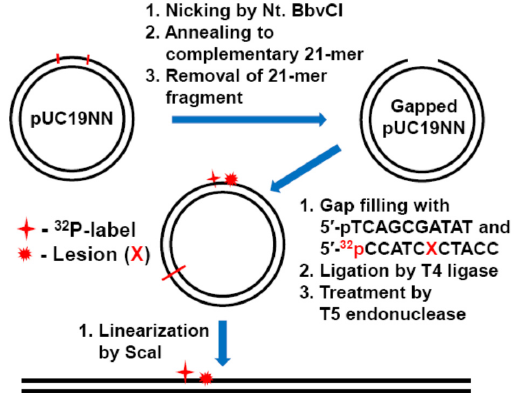
Figure 2. Covalently closed circular and linearized plasmid (2686 bp) containing site-specifically positioned guanine lesions (X) and a radioactive 32 P-internal label. The circular plasmid substrates were generated by gapped-vector technology from a pUC19NN plasmid containing two Nt. BbvCI restriction sites [21,22]. The linearized plasmid substrate with the lesion X positioned at the 945th nucleotide counted from the 5 ′ -end, was prepared by the selective cleavage of the circular plasmid with a unique ScaI restriction enzyme that generates blunt end cleavage products. The gapped plasmid derived from the nicking of pUC19NN with the Nt. BbvCI re- striction enzyme, was filled with the 5 ′ -phosphorylated oligonucleotides 5 ′ -pTCAGCGA- TAT and 32 P-endlabeled 5 ′ - 32 pCCATCXCTACC (where the lesion X = Gh, S -Sp, 8-oxoG, or cis -B[ a ]P-dG), and was ligated to the plasmid by T4 ligase. The reaction products were treated with T5 exonuclease to digest any linear and nicked plasmids [79–81]. The cleav- age of the covalently closed circular plasmid substrates by the unique restriction enzyme ScaI generates linearized plasmids with blunt ends with a guanine lesions (X) at the 945th nucleotide counted from the 5 ′ -end.